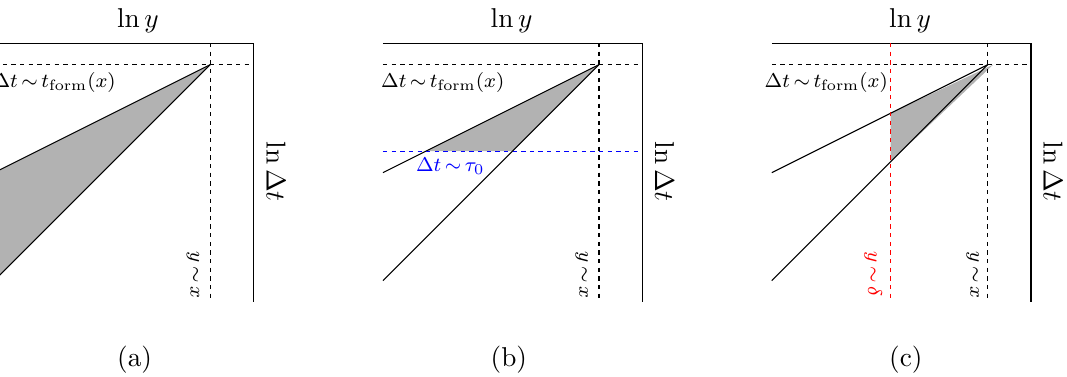
Figure 16 . The region of integration (3.23) giving rise to a double log in the ^ q approximation with (a) no cut o(cid:11), (b) the cut o(cid:11) (cid:1) t used in our calculations. See text for